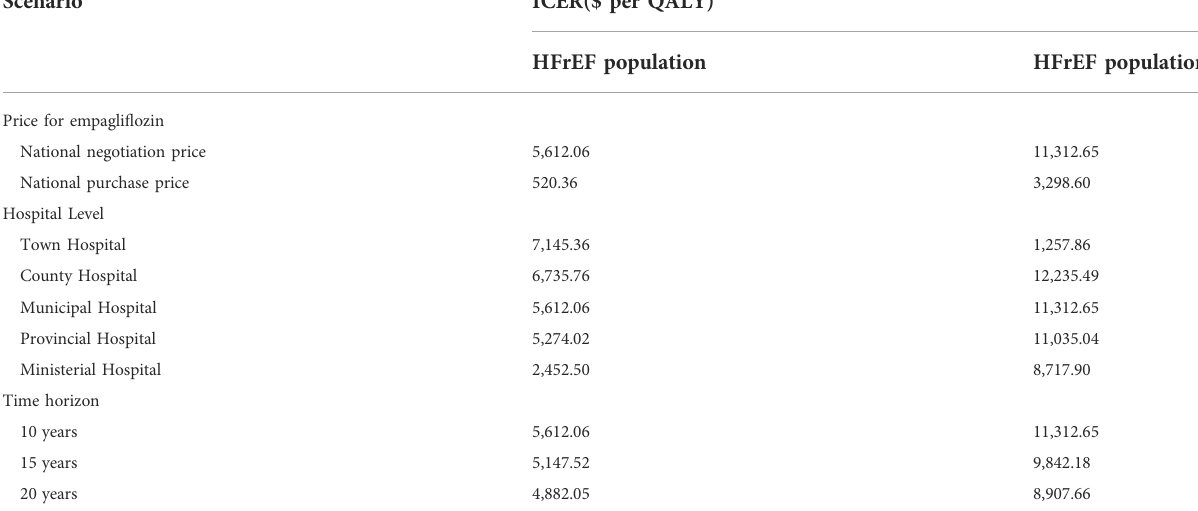
TABLE 4 The result of scenario analyses presented as